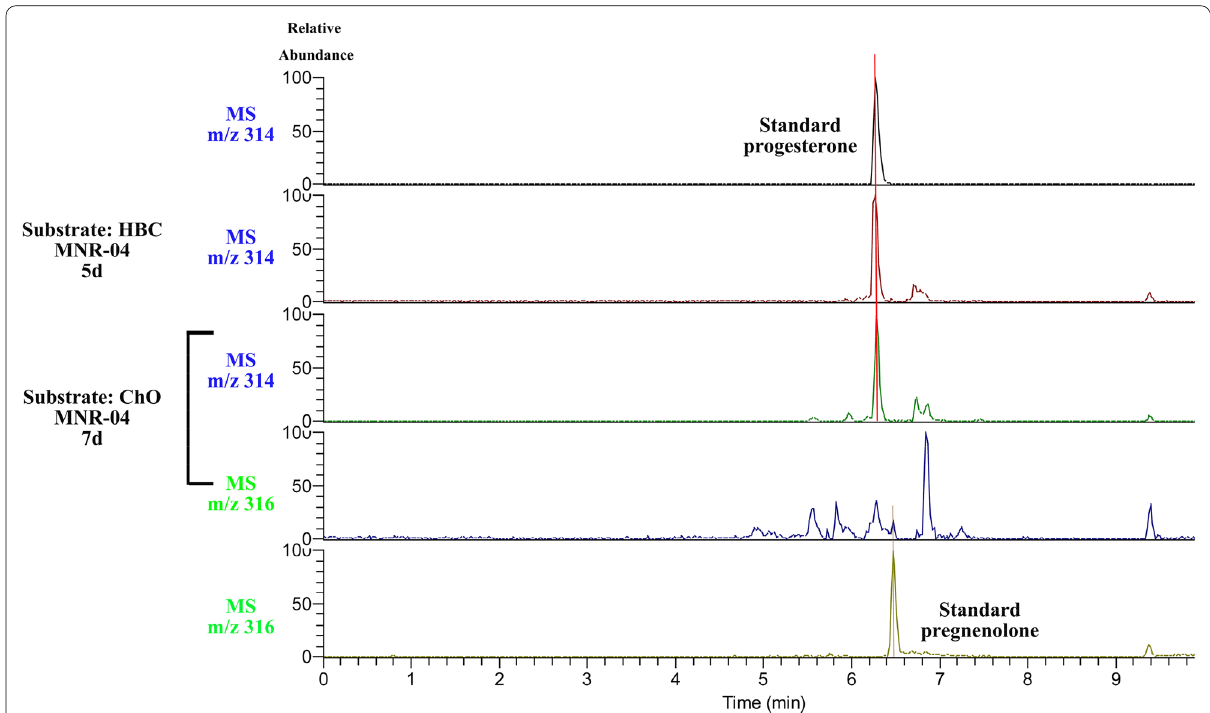
Fig. 3 Analysis of products by high‑resolution mass spectrometry. The substrates HBC and cholesterol (ChO) were biotransformed by MNR‑04 fermentation,